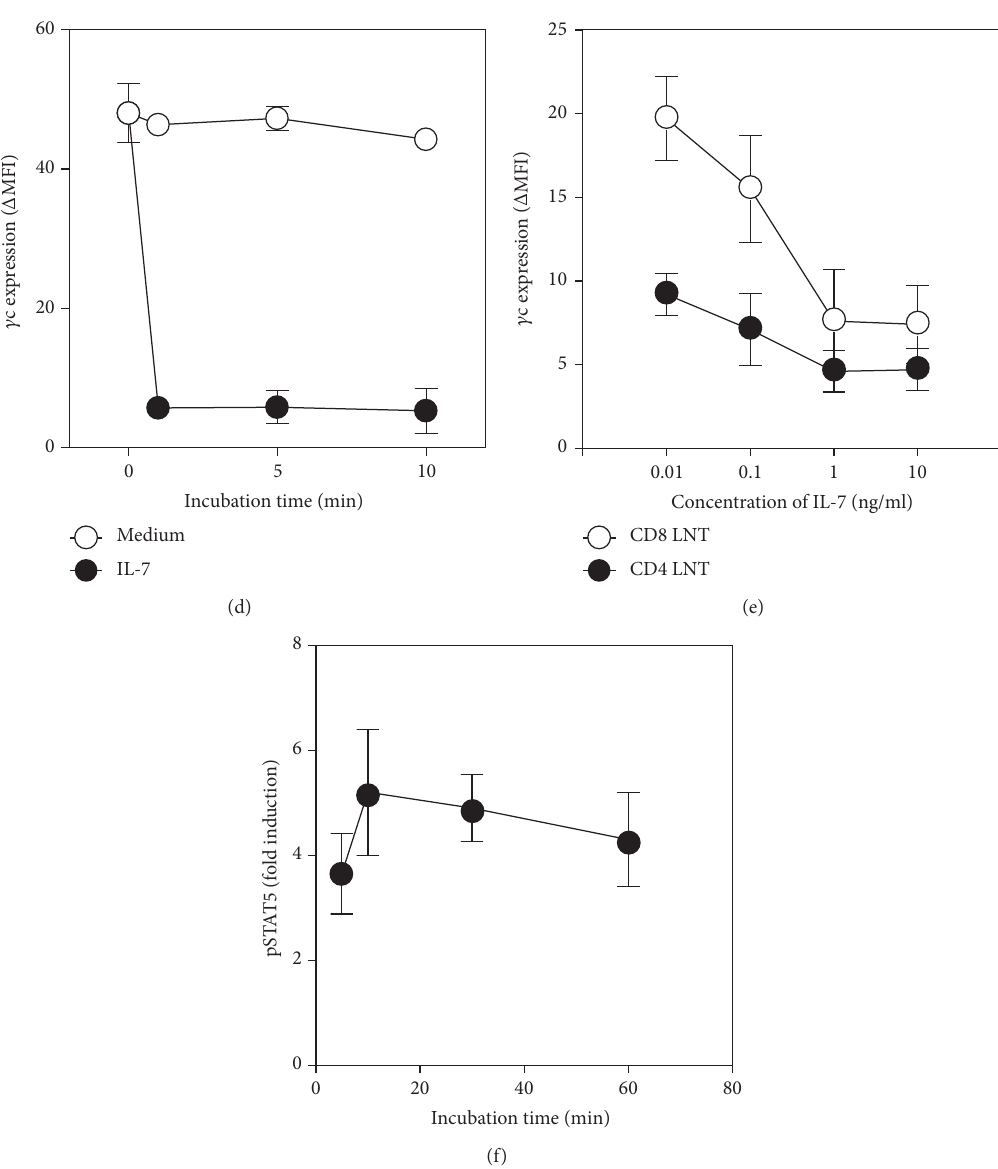
Figure 1: Reduction of 𝛾 c surface expression with IL-7. (a) Time dependent kinetics of 𝛾 c expression with IL-7. T cells were stimulated in the presence or absence of IL-7, and the cytokine receptor expression was analyzed by FACS at the indicated time points. The maximum value of 𝑥 -axis is 250 for 10-minute to 4-hour histograms and is 200 for 16-hour histogram. Histograms are representative of six independent experiments. (b, c) Summary of flow cytometry analysis for 𝛾 c (4G3) and IL-7R 𝛼 expression kinetics in thepresence of IL-7.Data aresummary of six independent experiments (mean and SEM). (d) The early time point kinetics of 𝛾 c (4G3) expression in the presence of IL-7. Data are summary of three independent experiments (mean and SEM). (e) Kinetics of 𝛾 c (4G3) surface expression on T cells under different concentration of IL-7. T cells were stimulated with an indicated concentration of IL-7 for 10 minutes, and the surface 𝛾 c expression was analyzed by FACS. Data are summary of three independent experiments (mean and SEM). (f) Freshly isolated LNT cells from WT mice were stimulated with IL-7 for the indicated time and assayed for intracellular pSTAT5 content. Fold induction of pSTAT5 content was calculated to that of fresh LNT cells, set as 1. Data are summary of two independent experiments (mean and SEM).